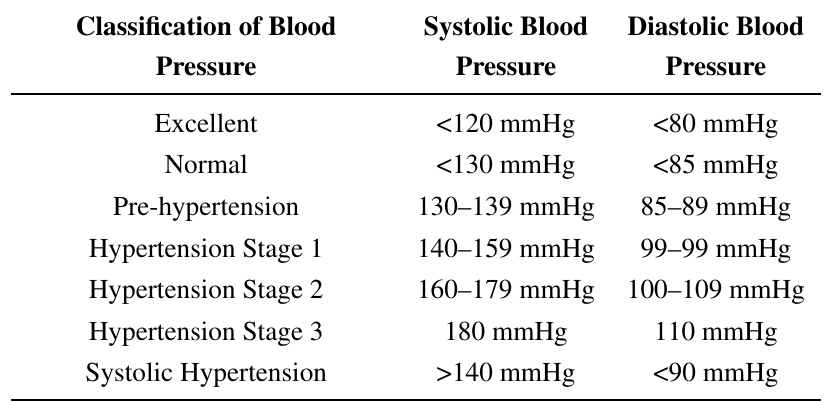
Table 8. Classification of Hypertension by Brazilian Cardiology